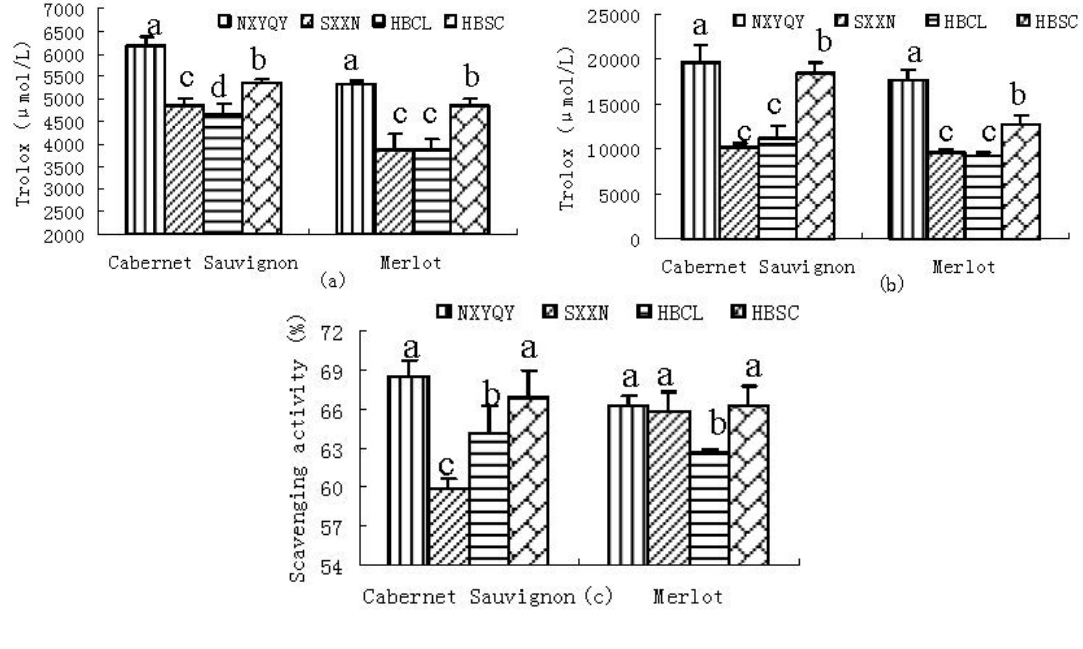
Figure 1. Antioxidant activity of the extracts of Cabernet Sauvignon and Merlot grape berries from four different wine grape-growing regions, determined using three kinds of assays. ( a ) 2,2-Diphenyl-1-picrylhydrazyl (DPPH) radical (DPPH•) scavenging activity of samples; ( b ) Cupric ion reducing antioxidant capacity (CUPRAC) of samples; and − ) scavenging activity (SRSA) of samples. Data are expressed as ( c ) Superoxide radical (O 2 mean ± standard deviation. Different letters above the bars for the same cultivars indicate significant difference at p < 0 . 05 (Duncan’s